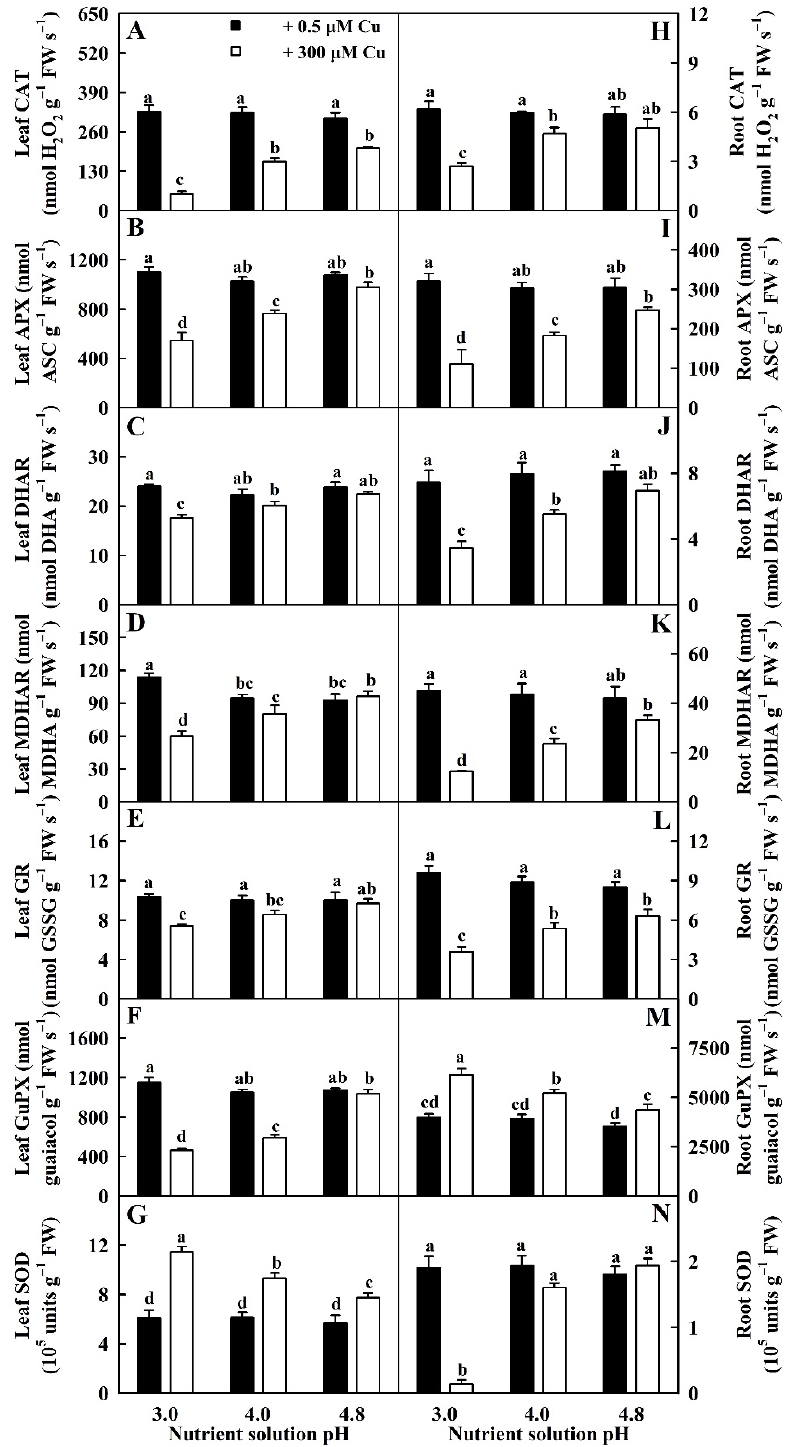
Figure 2. Impacts of Cu–pH interactions on the activities of CAT ( A , H ), APX ( B , I ), DHAR ( C , J ), MDHAR ( D , K ), GR ( E , L ), GuPX ( F , M ), and SOD ( G , N ) in leaves and roots. Bars represent means ± SE ( n = 4). Different letters above the bars indicate a significant difference at p < 0.05. We found that Cu toxicity reduced the activities of ATP sulfurylase (ATPS), adeno- sine 5′ -phosphosulphate reductase (APR), cysteine synthase (CS), glutamine synthetase (GS), and glutathione S- transferase (GST) in leaves and roots and γ -glutamylcysteine syn- thetase (γGCS) in roots more at pH 3.0 than at pH 4.8 . We also found that Cu toxicity did